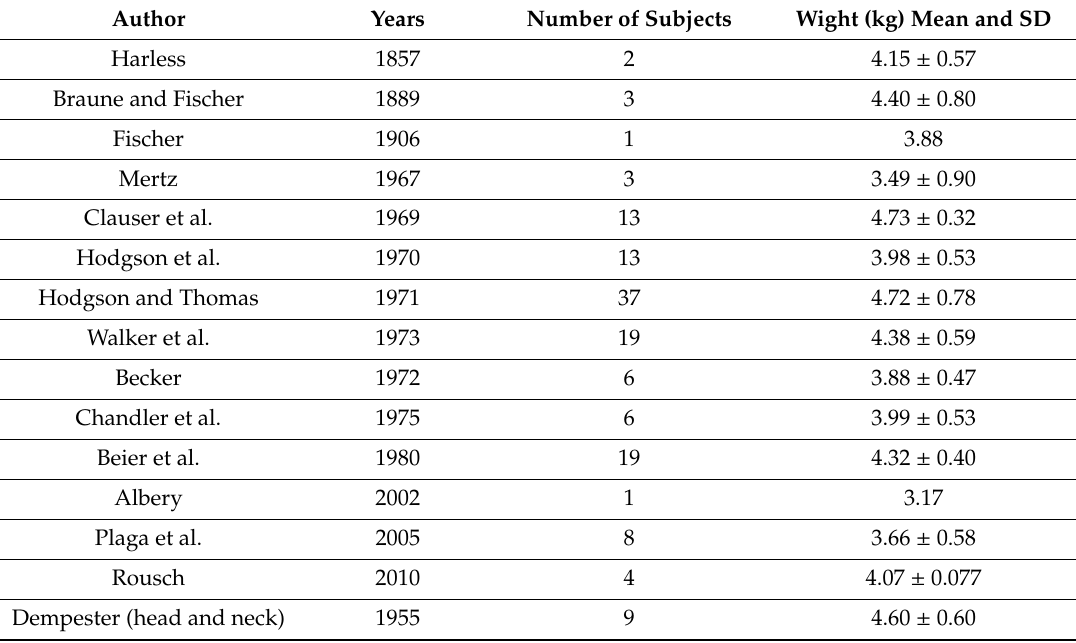
Table 1. Mean ± standard deviation of male head mass measured on human specimens. Due to the di ffi culty of the technique, the di ff erent dissection methods, the age span (19 to 70) the results are quite homogeneous. Only nine female specimens were analyzed in literature (seven in Plaga et al.’ and two in Beier et al.’ studies). Modified from